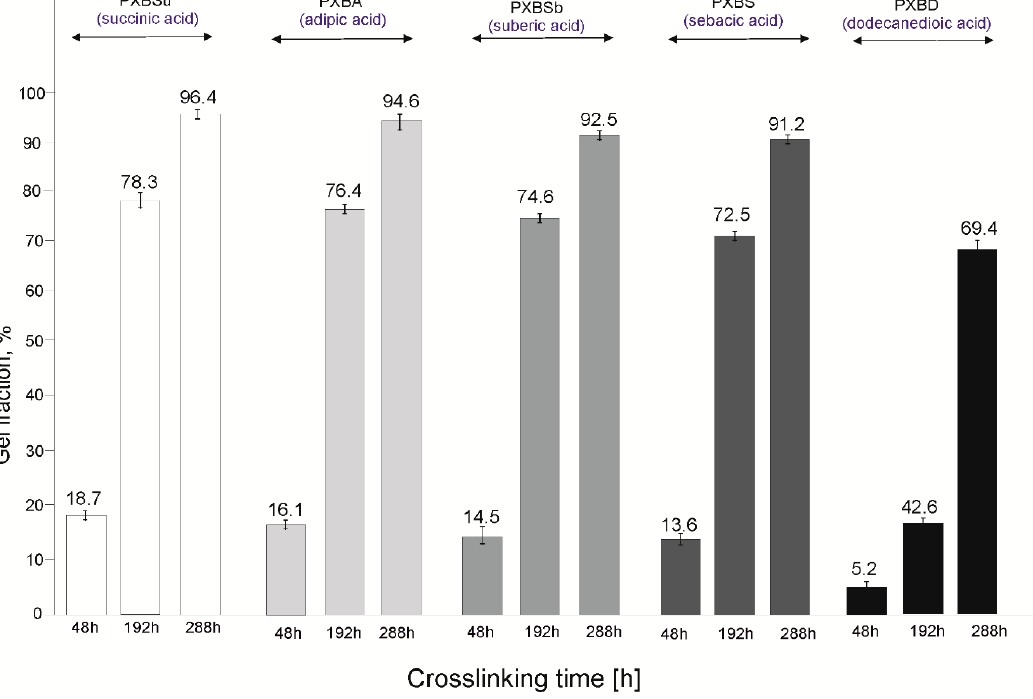
Figure 10. Gel fraction results for PXBSu, PXBA, PXBSb, PXBS and PXBD polymers.